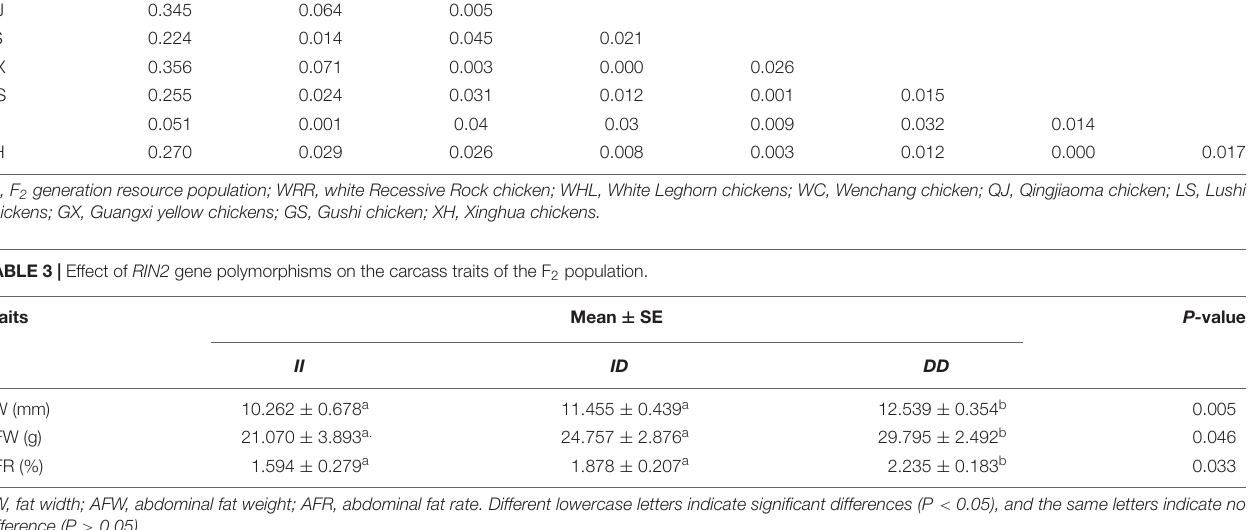
Frontiers in Genetics |